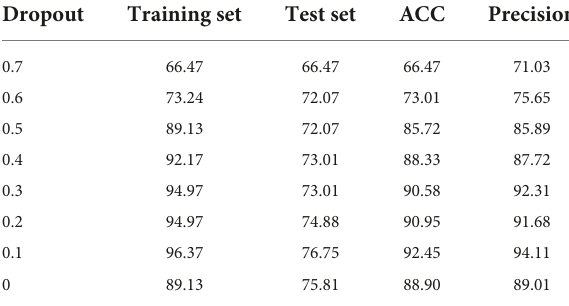
TABLE 3 Performance of SA-Bi-LSTM network